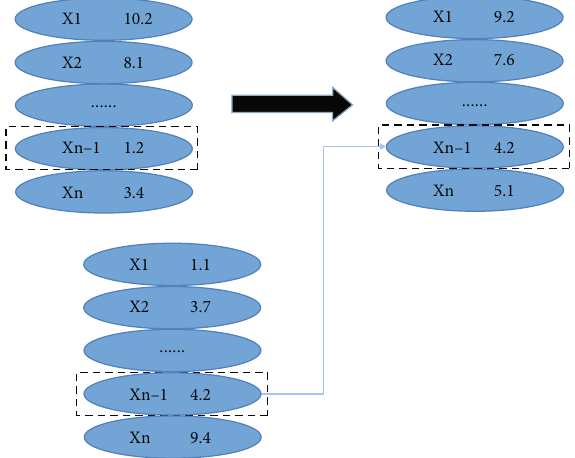
Figure 4: Particles fi nding the optimal solution with global best particle.